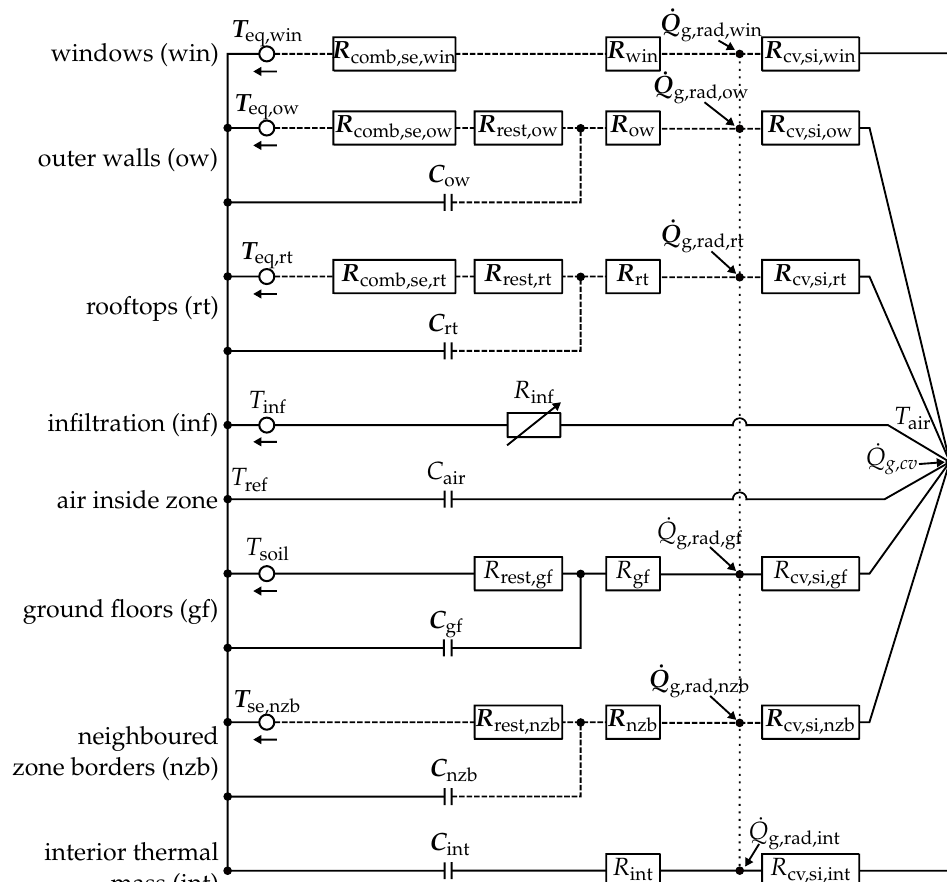
Figure 4. Thermal network of the used thermal zone model in the style of the electrical analogy networks for the AixLib models by Lauster [44]. Dashed lines and bold variables indicate parallel connections and components modelled as arrays. R comb,se,x is the thermal resistance for the heat exchange between the exterior surface of a (lumped) building element x and the ambience. R x,rest and R x form the thermal resistance of the element itself, while C x is its thermal capacitance and R cv,x is the convective thermal resistance between its interior surface and the zone air temperature T air . To maintain clarity, the resistances representing the radiation exchange between each pair of interior surfaces are replaced by a dotted line. Heat gains from solar radiation, internal gains, and heating are split into a convective part ˙ Q g,cv and radiative parts onto each interior surface ˙ Q g,rad,x